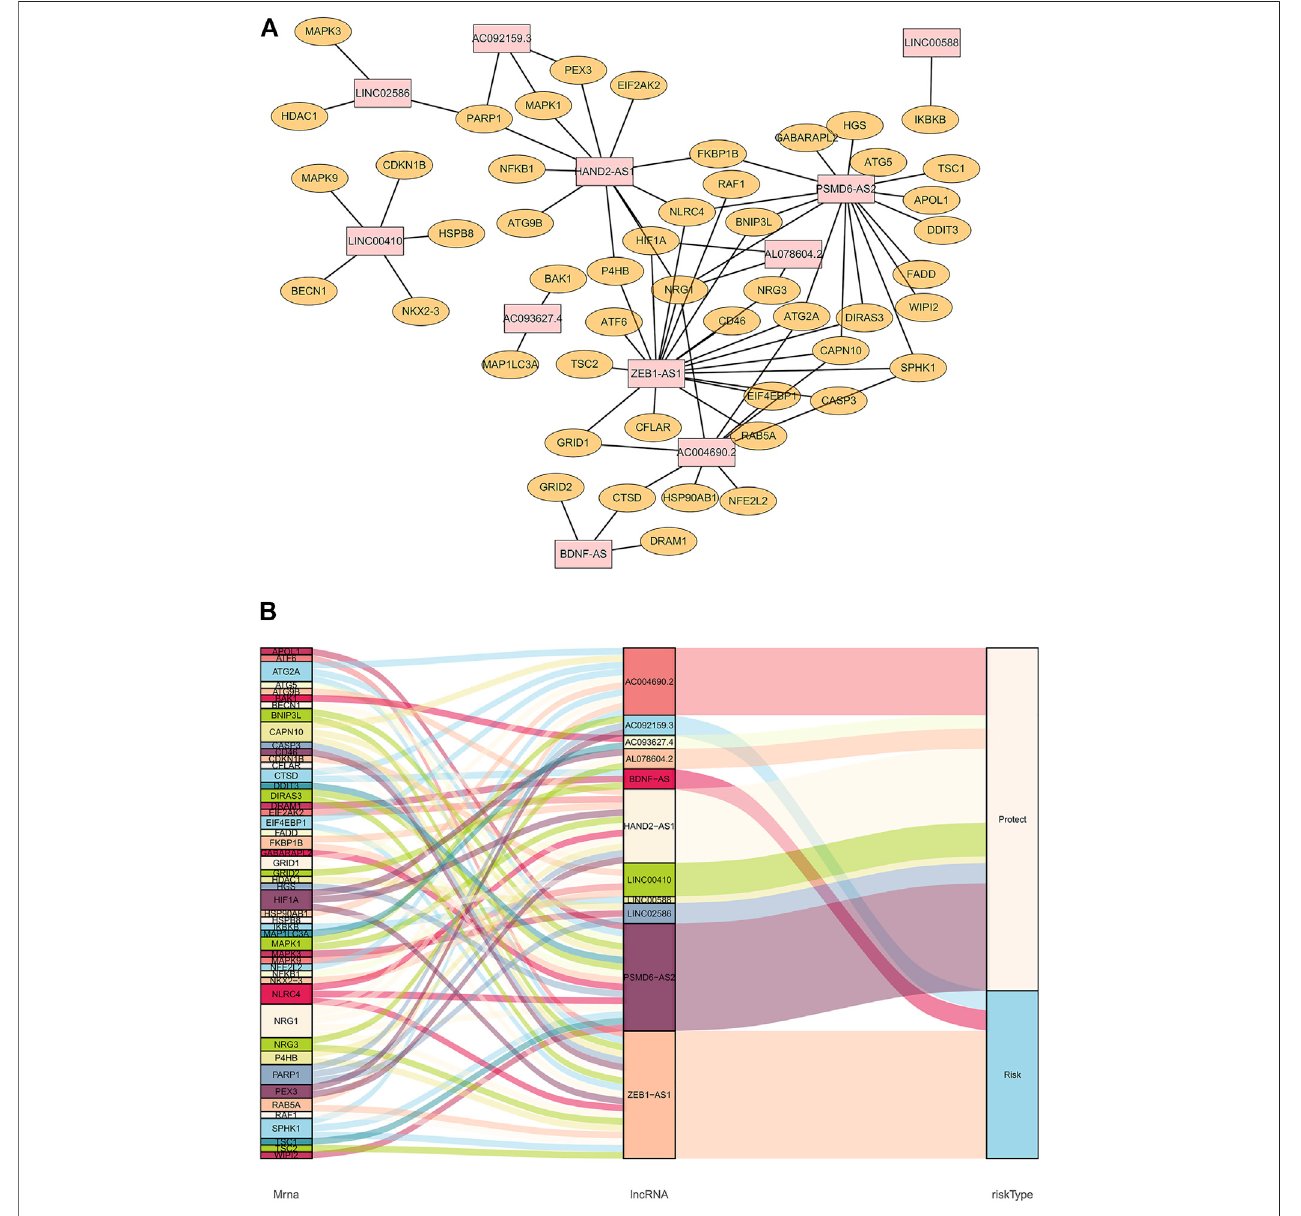
FIGURE1| Co-expressionofautophagy-relatedgenesandlncRNAs. (A) :Orangenodesareautophagy-relatedgenes,andpinknodesaretheirrelatedprognostic lncRNAs. The network was generated by Cytoscape 3.7.2. (B) : Sankey diagram of autophagy-related genes, lncRNAs, and their risk types in patients ’ prognosis.